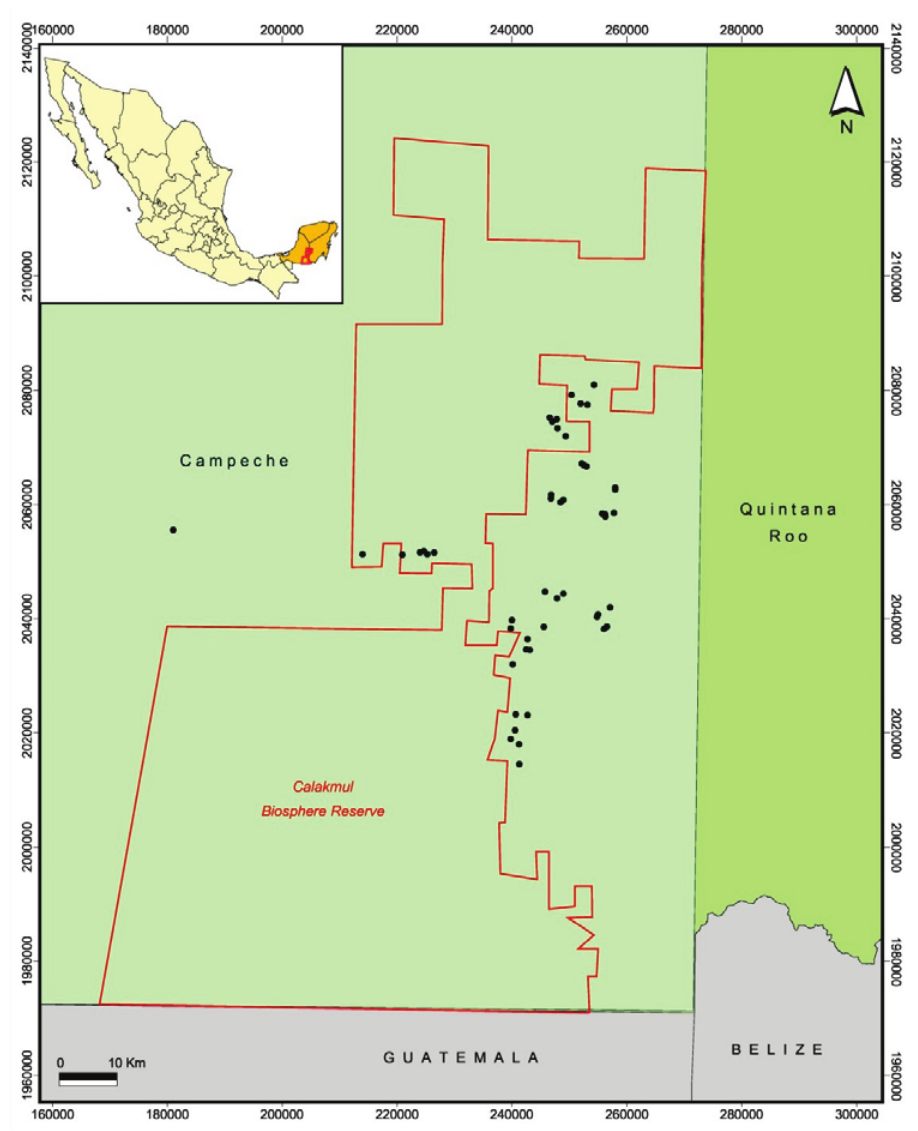
Figure 1. Map of the study region in Southeastern Mexico, showing the location of the 50 forest plots